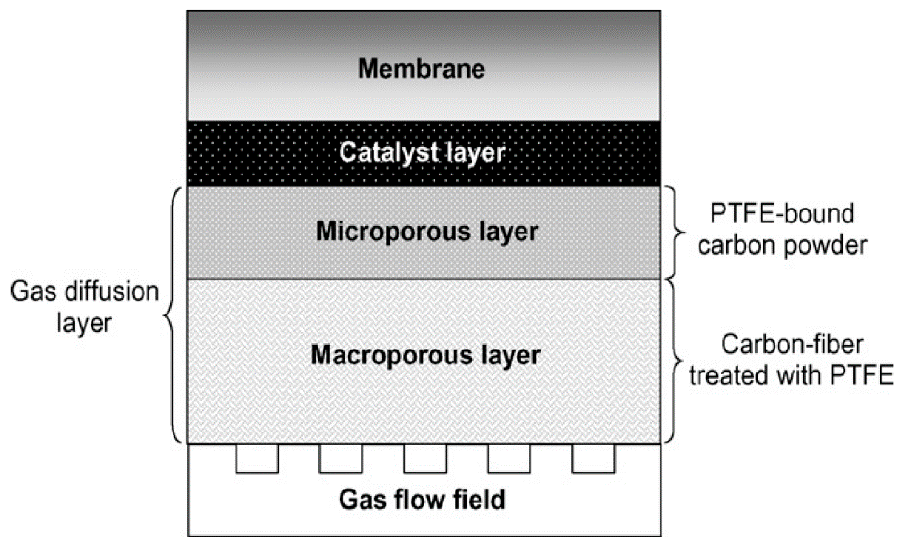
Figure 2. Schematic diagram of a PEMFC GDL [18].